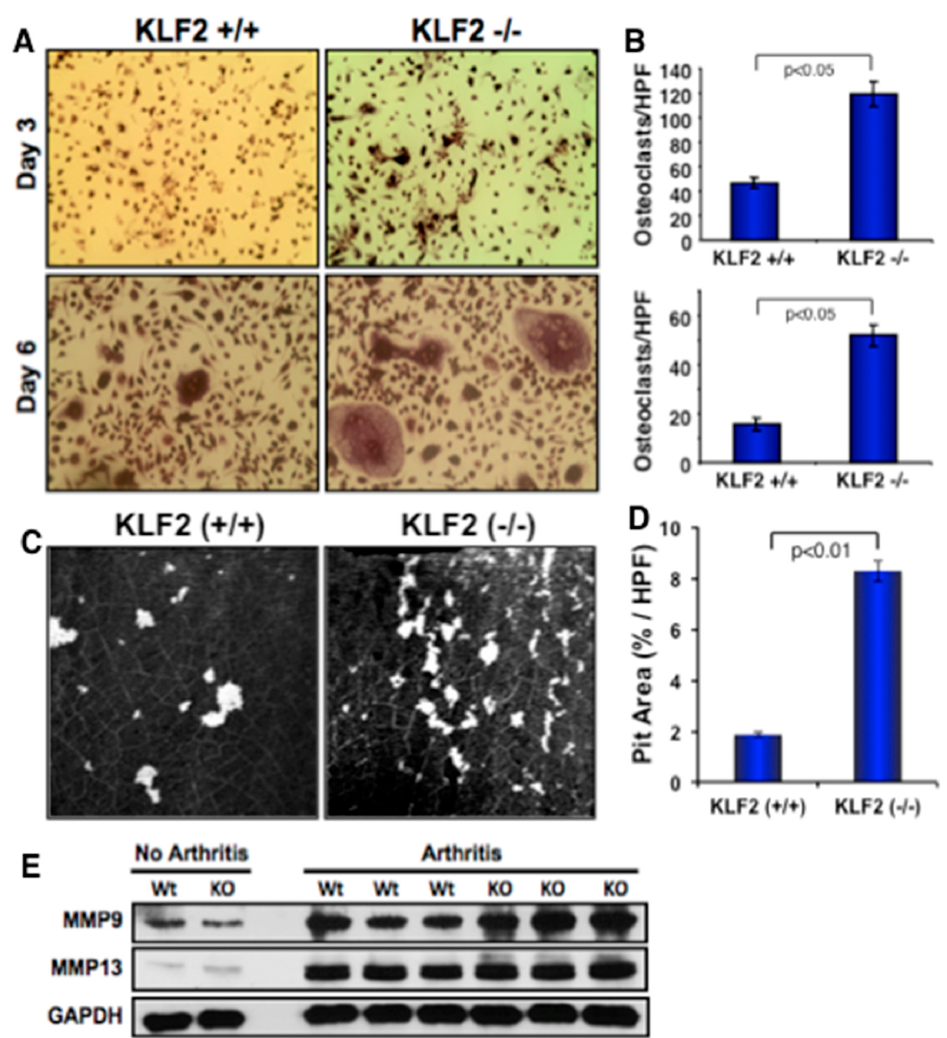
Figure 5. Monocyte-specific KLF2 deficiency enhanced osteoclast differentiation and MMP expression. ( A ) Differentiation of osteoclasts was evaluated on days 3 and 6 in bone marrow cells